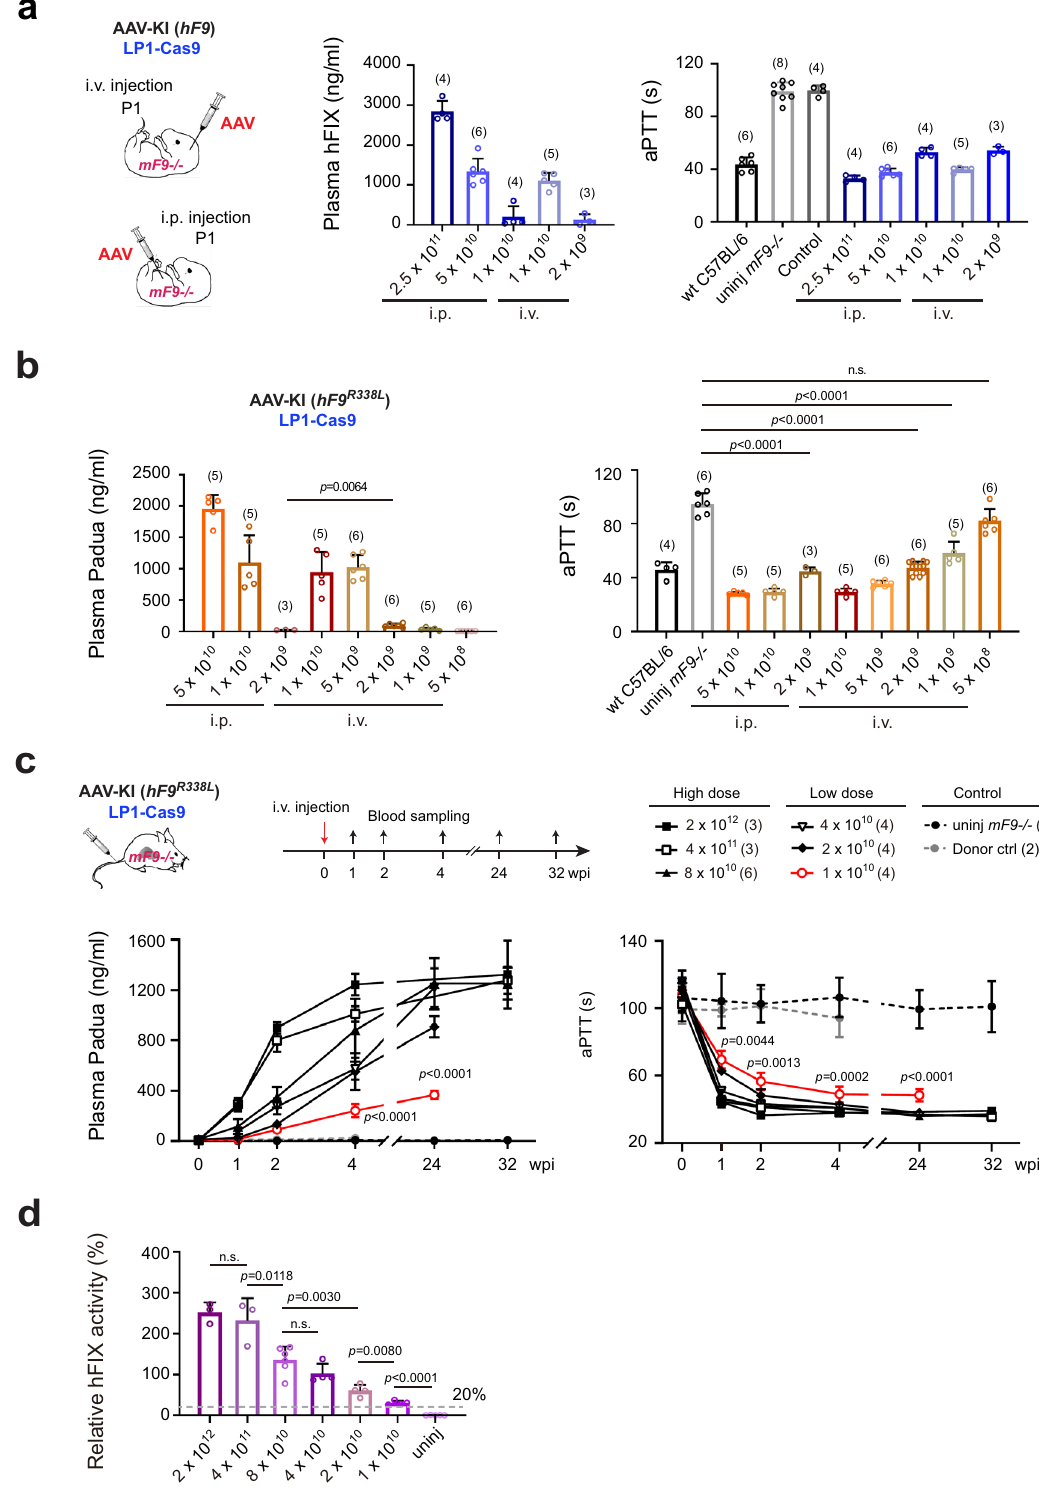
i.v. injection wpiBlood